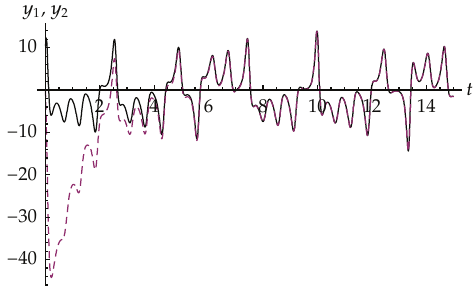
Figure 13: Synchronized signals y 1 ; y 2 (cid:3) α (cid:8) 0 . 99 (cid:4) .